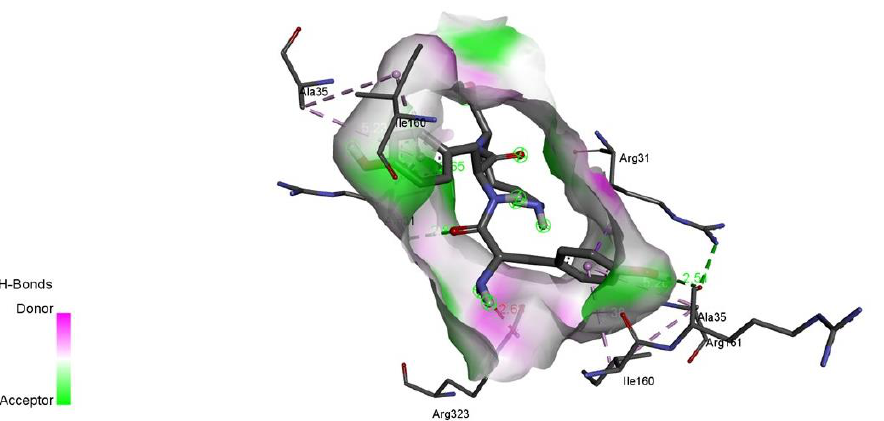
Figure 3. Example of 3D interaction of ligand-protein -YYV.